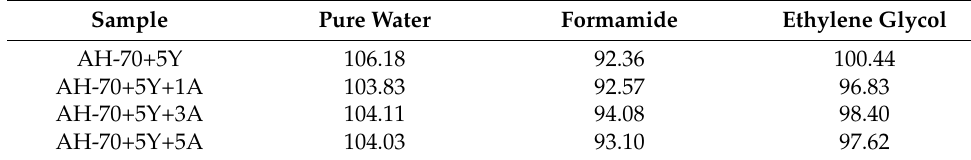
Table 5. Contact angle test results ( ◦ ).